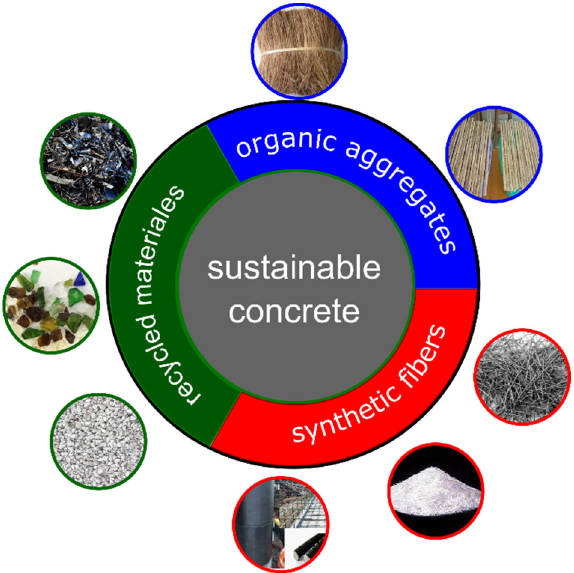
Figure 1. Diagram of different material types used in sustainable concrete.